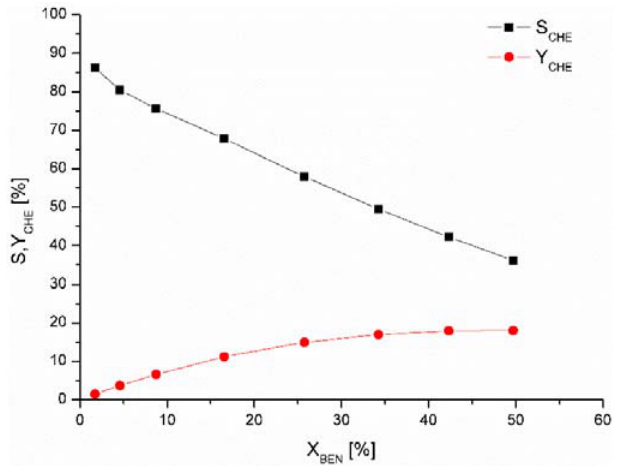
Figure 3. Cyclohexene selectivity and yield against the conversion of benzene. (Reaction conditions: 1.5 g 2Ru/La 2 O 3 –ZnO, 4 mg NaDCA, 20 bar H 2 , 100 mL H 2 O, 50 mL benzene, 1000 rpm, 150 °C).